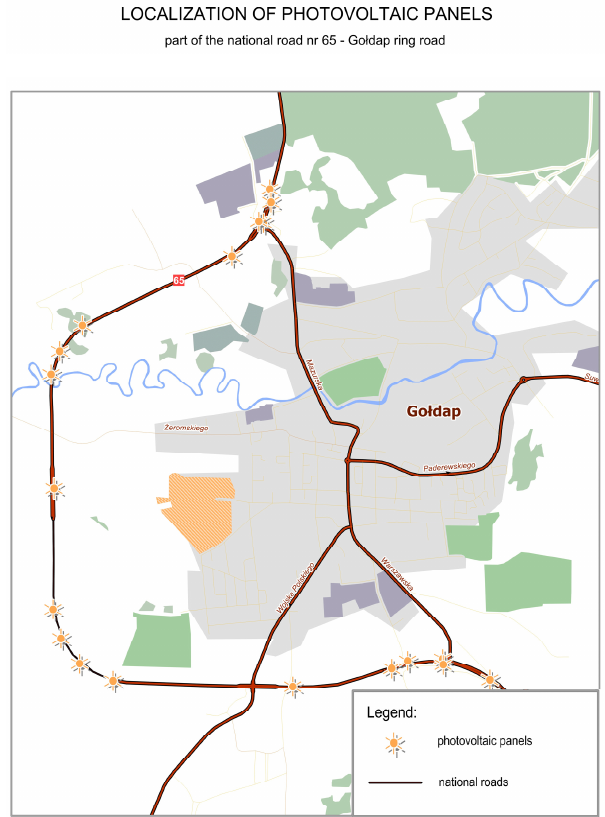
Figure 8. Location of signs powered by photovoltaic technology on the Gołdap bypass. Source: